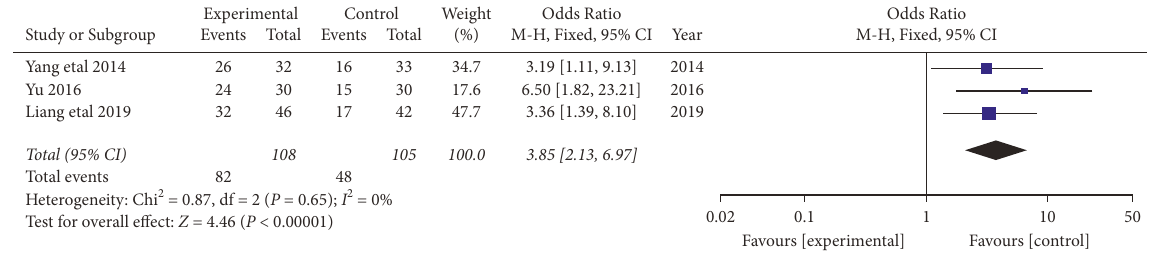
Figure 5: Comparison of GTW combined with RASI versus GTWTR-3 months.